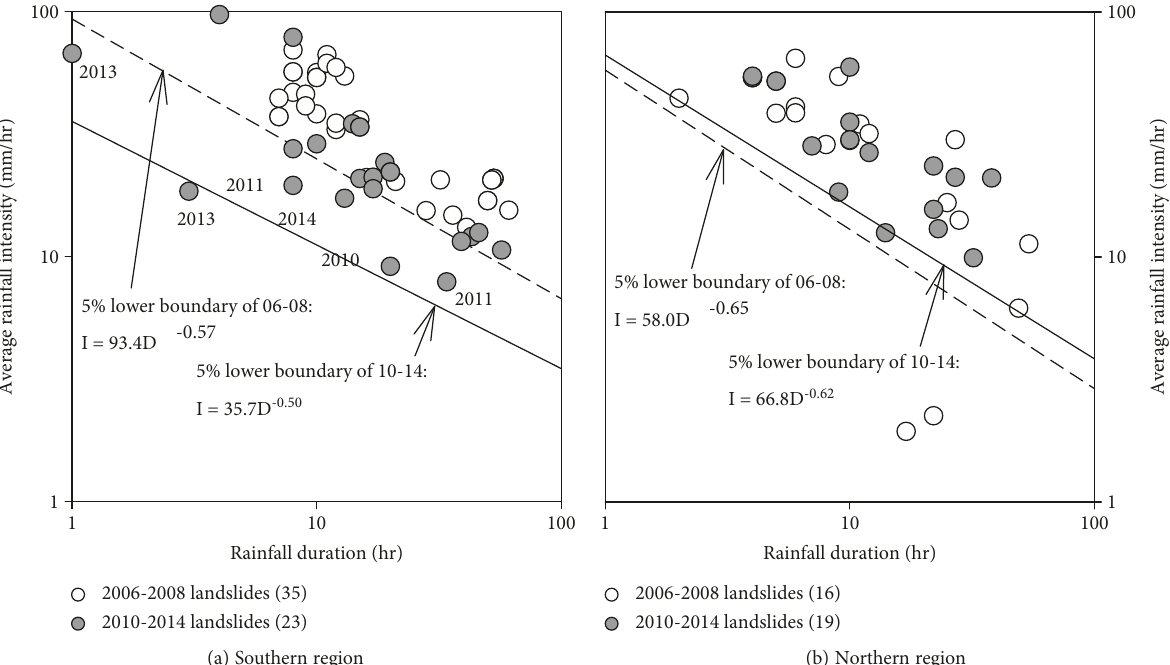
Figure 6: The lower boundaries of rainfall condition for triggering landslides in 2006 – 2008 and 2010 – 2014. (a) 58 landslides in the southern region. The numbers labeled around the data lower than the lower boundary of 06 – 08 mean the occurrence year of event. (b) 35 landslides in the northern